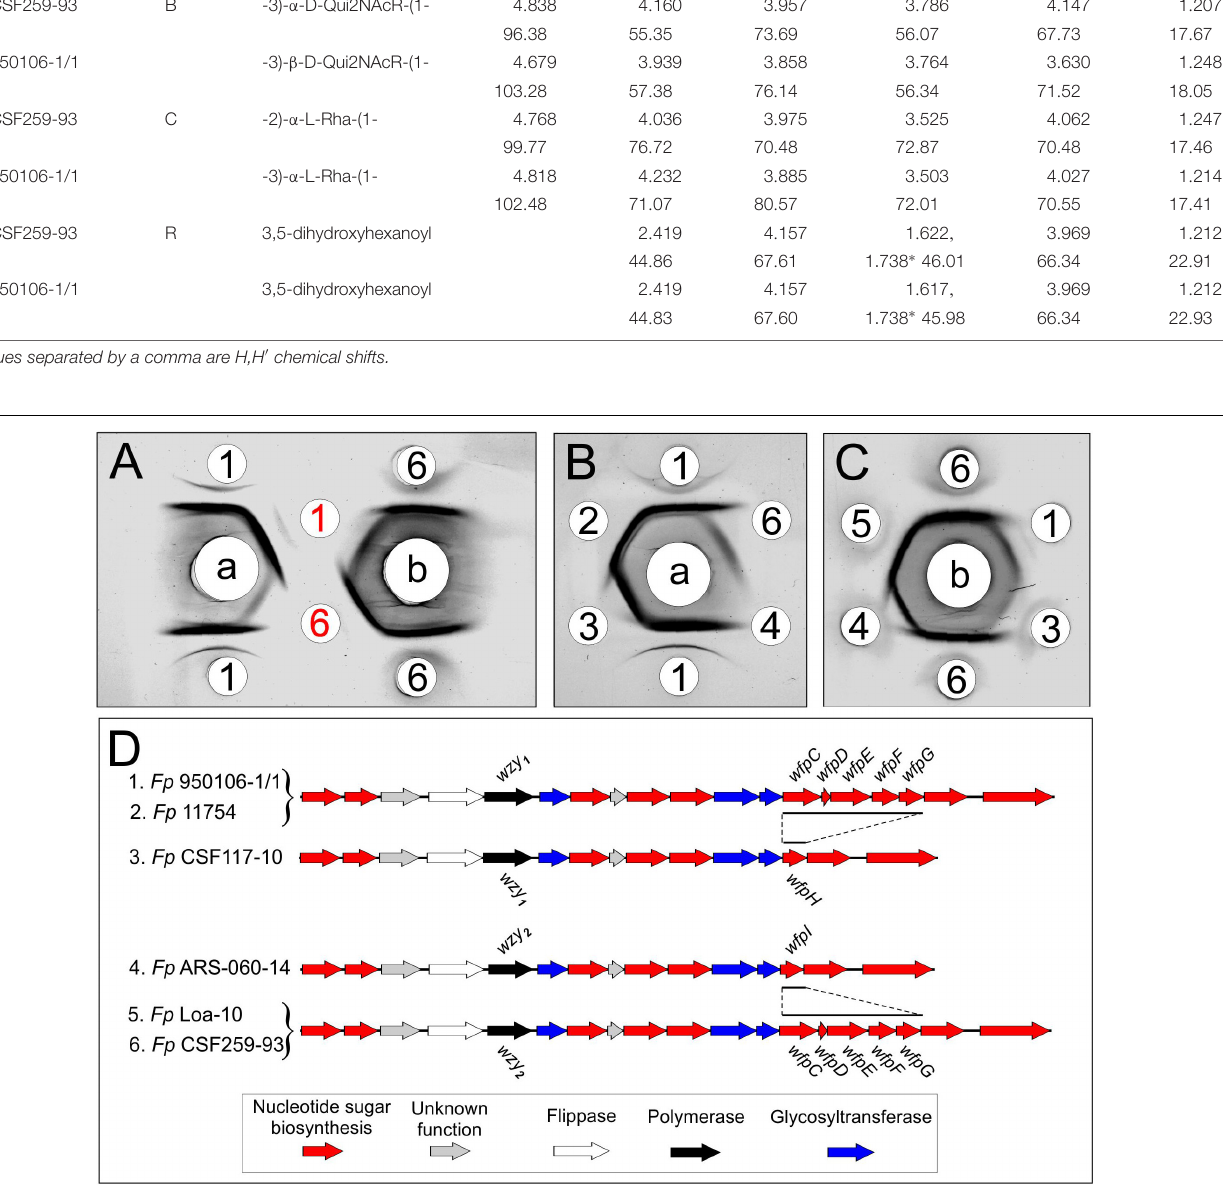
FIGURE 2 | Immunodiffusion of Fp O-antigens: (A) comparison of O-PS and LPS of Fp 950106-1/1 and Fp CSF259-93; (B) comparison of LPS of Fp 950106-1/1 with LPS of other Fp strains; (C) comparison of LPS of Fp CSF259-93 with LPS of other Fp strains. Center wells contained (a) anti- Fp 950106-1/1 serum or (b) anti- Fp CSF259-93 serum. Outer wells contained (1) Fp 950106-1/1 LPS, (red 1) Fp 950106-1/1 O-PS, (2) Fp 11754 LPS, (3) Fp CSF117-10 LPS, (4) Fp ARS-060-14 LPS, (5) Fp Loa-10 LPS, (6) Fp CSF259-93 LPS or (red 6) Fp CSF259-93 O-PS. Genes that distinguish the O-PS loci of different Fp strains are labeled in panel (D)